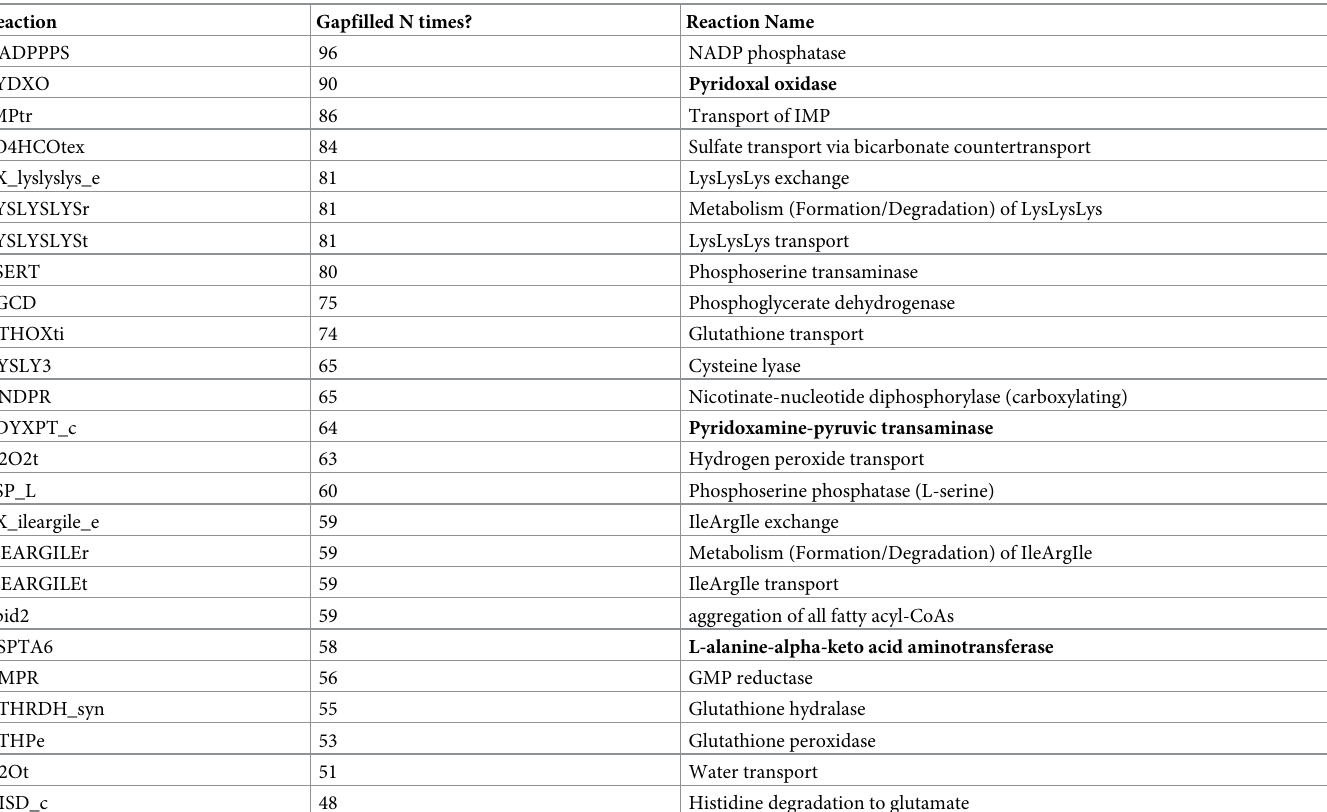
Table 2. Most frequently gapfilled reactions. These reactions (in the BiGG namespace) were the most commonly added reactions as a result of all gapfilling steps.